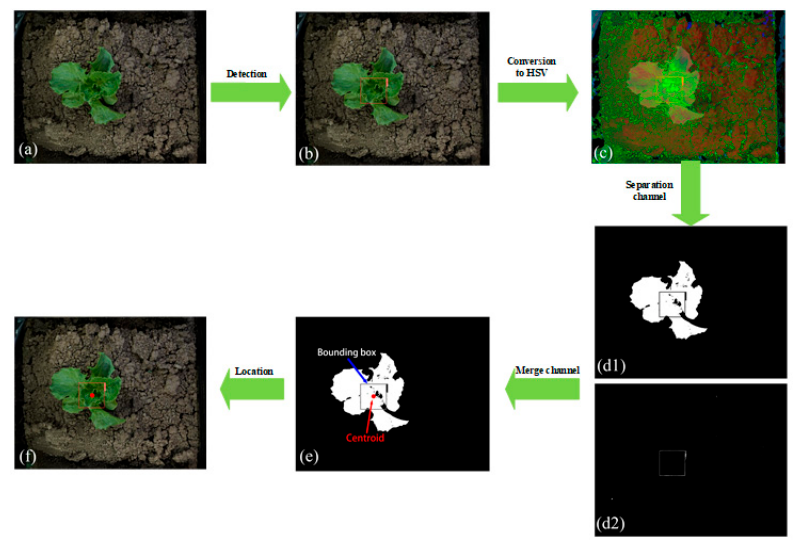
Figure 7. The visualization process of center positioning algorithm; ( a ) the original image captured, ( b ) the detection result of the deep learning model, ( c ) the color space image of HSV (the image of detection result is converted from RGB to HSV channel by image processing), ( d1 , d2 ) the separation results of crop and bounding box in different channels, ( e ) the result of merging color channel, ( f ) the final localization result.